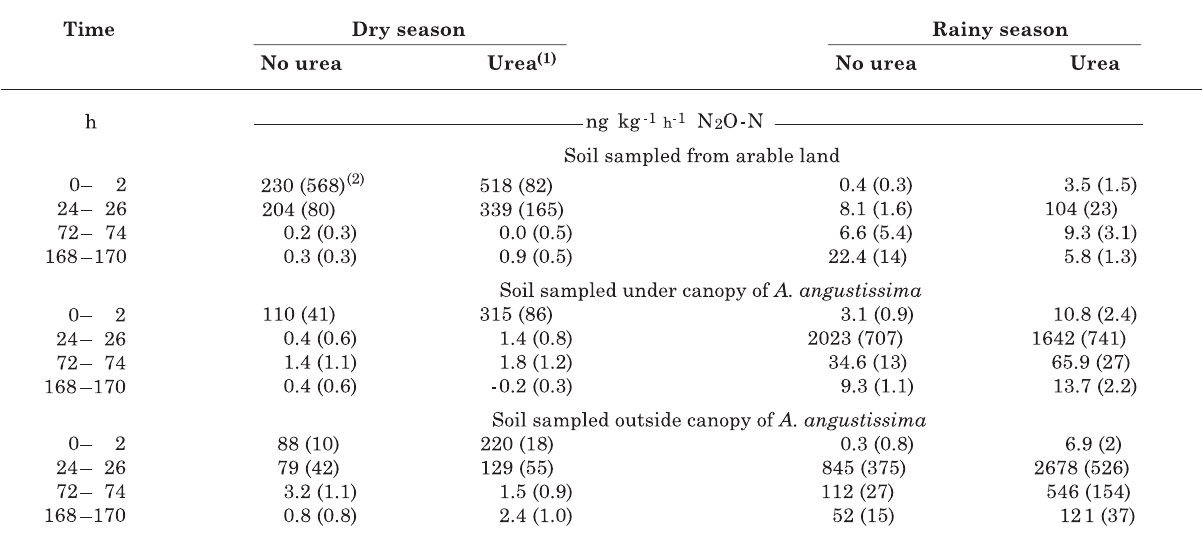
Table 4. N O emission from arable soil and soil sampled under and outside the canopy of Acacia angustissima 2 in the dry and rainy season and adjusted to 100 % water-holding